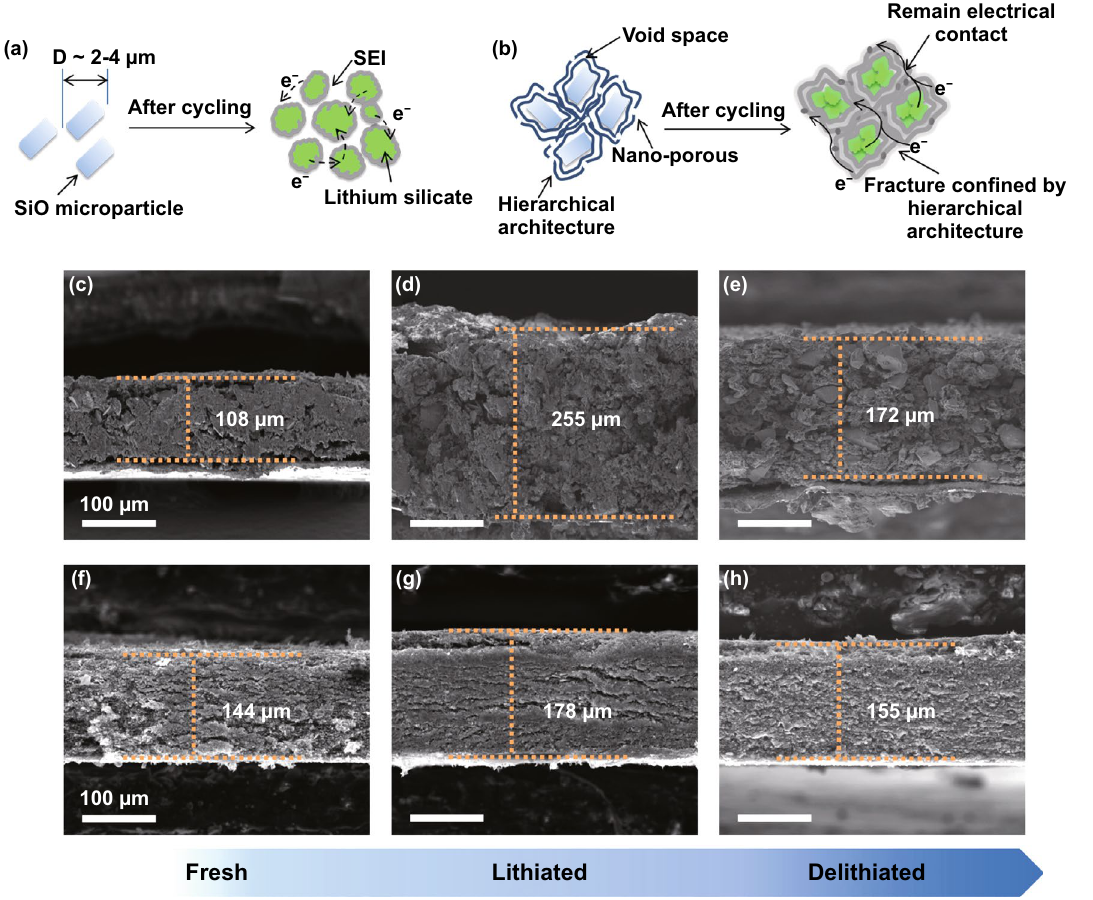
Fig. 4 The electrode morphology characterization and structure analysis during the charge/discharge state. a , b Schematic illustration of the structural change in conventional slurry SiO electrode and LHGF/SiO electrode after cycling. Cross-sectional SEM images of conventional slurry SiO electrode (containing Cu current collector) at c fresh, d lithiated and e delithiated states. Cross-sectional SEM images of LHGF/SiO electrode at f fresh, g lithiated and h delithiated